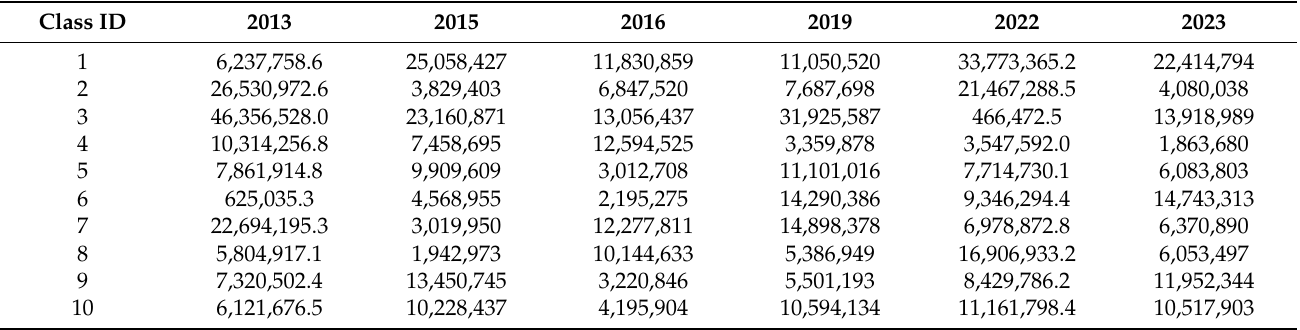
Table 2. Results of the k-means classification of the Landsat-8 OLI images for Qena Bend area 1